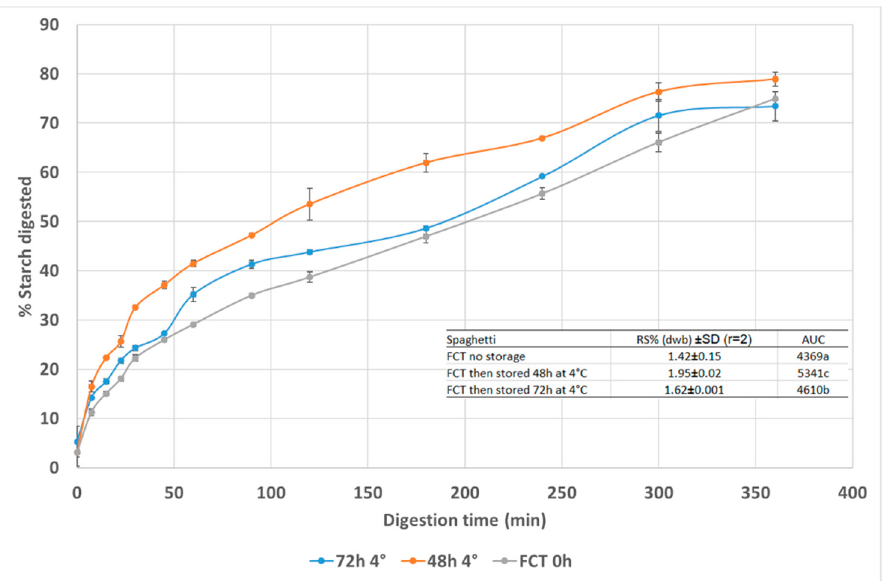
Figure 3. Effect of cold storage duration of fully cooked spaghetti on starch digestion curves. Data points are mean values (n = 2) with error bars as SD. RS% = resistant starch content; AUC = area under the starch digestion curve.